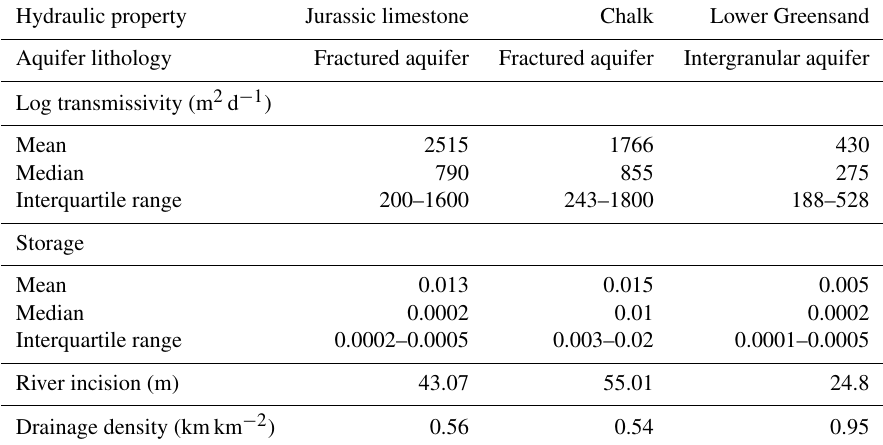
Table 1. Range of hydraulic aquifer properties (where available) of the main aquifers in the Thames catchment after Allen et al. (1997) and Bloomfield et al. (2011). It should be acknowledged that the storage values reported below may relate to both confined (elastic) storage coefficients and specific yield values, depending on the approach taken to analyse the pumping tests on which they are derived. This may be particularly likely in the